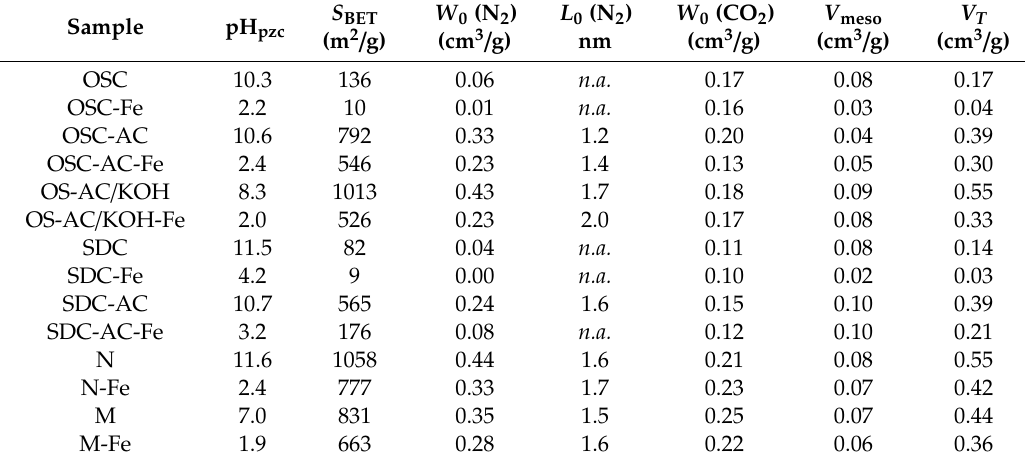
Table 3. pH pzc and textural characteristics of supports and corresponding catalysts.